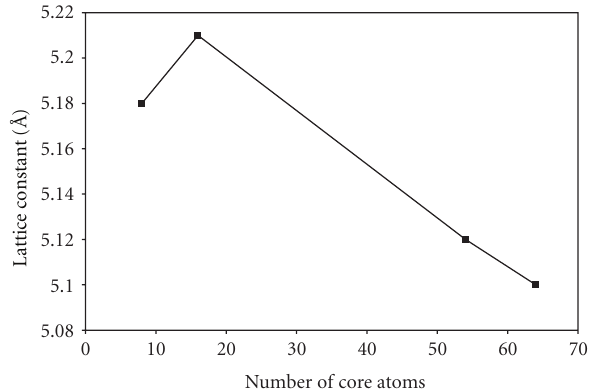
Figure 8: Valence band width variation as a function of number of core atoms in LUC-DFT method for GaAs